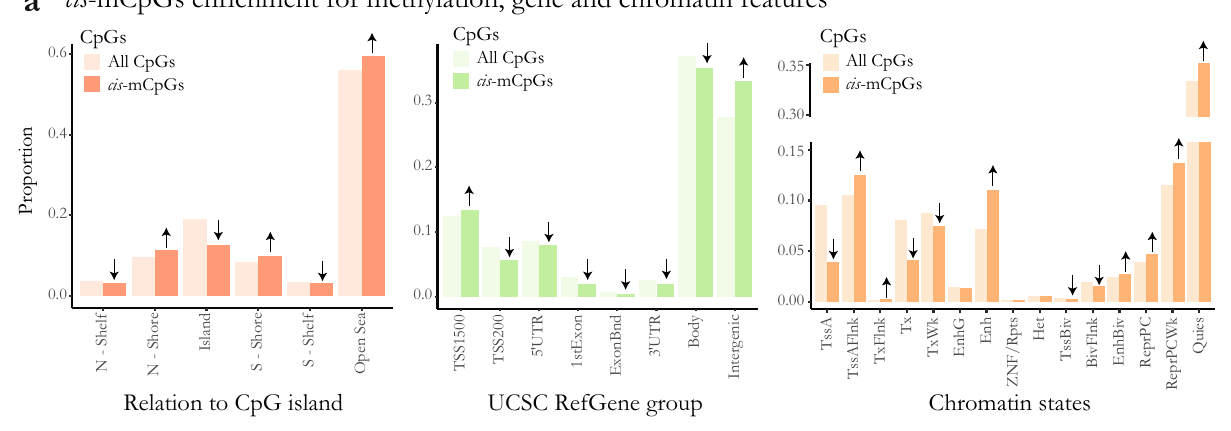
b Comparison with cis -mQTL results from the BLUEPRINT study (naïve CD4 + T cells)